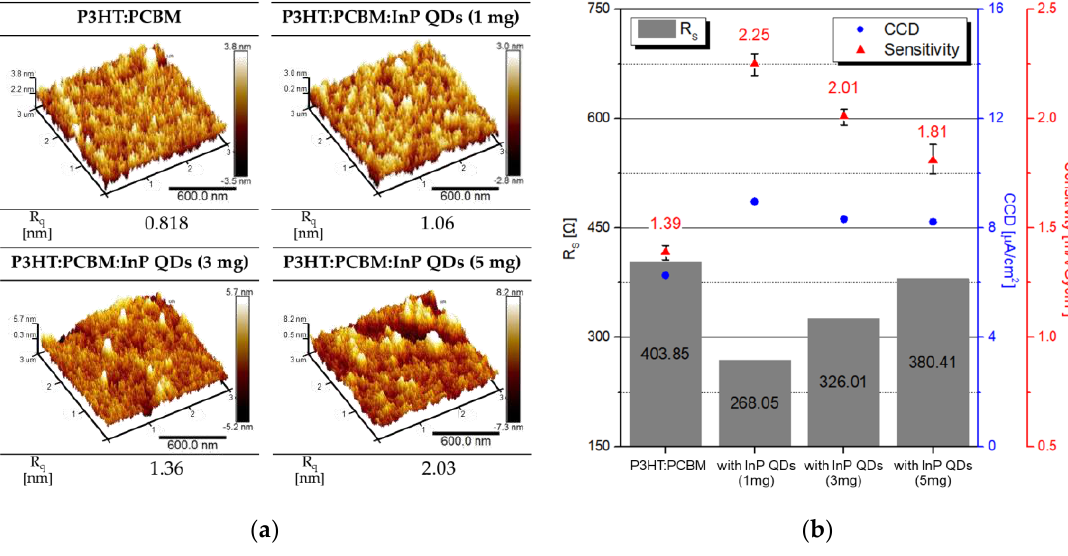
Figure 6. ( a ) The atomic force measurement (AFM) image and R q depending on the P3HT:PC 70 BM:InP QDs (0, 1, 3, and 5 mg) films and ( b ) the parameters of R S , CCD, and sensitivity of detector for different InP QD amounts.